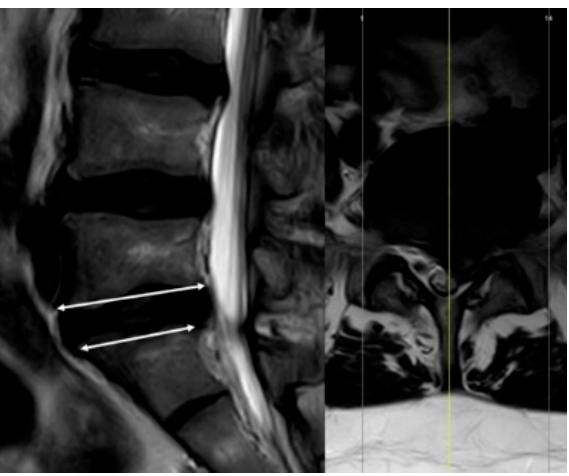
Figure 1. Location of measurement.